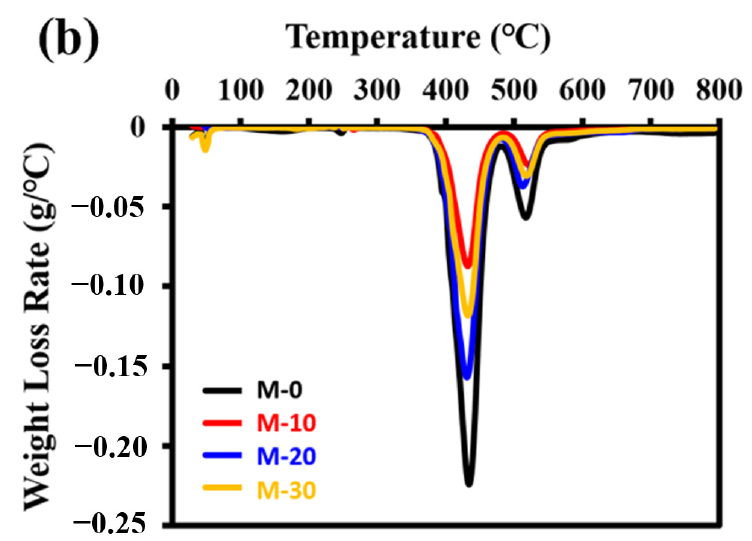
Figure 7. ( a ) The TGA profile and ( b ) the DTG analysis of the prepared membranes.